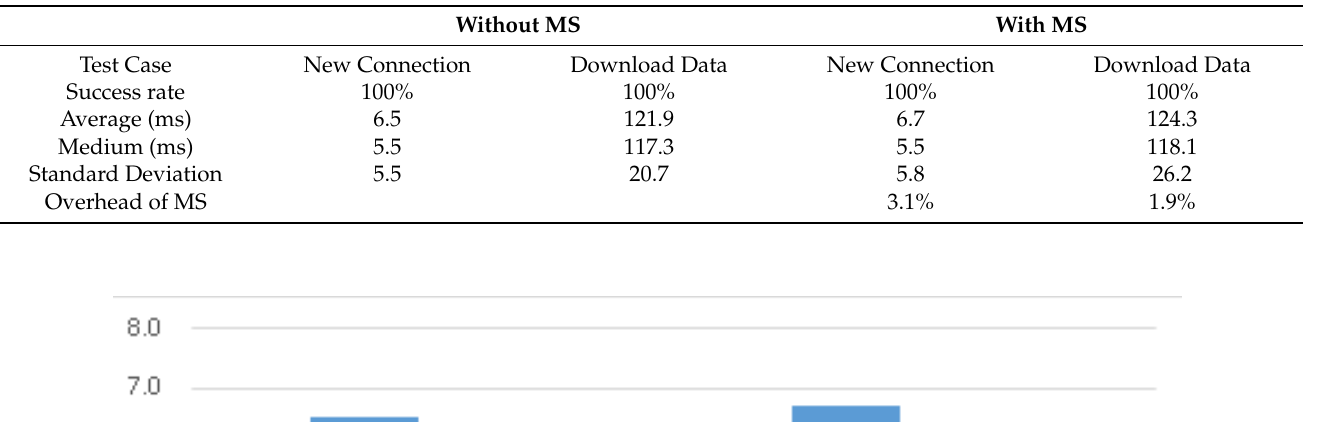
Table 2. Testing existing functionality.